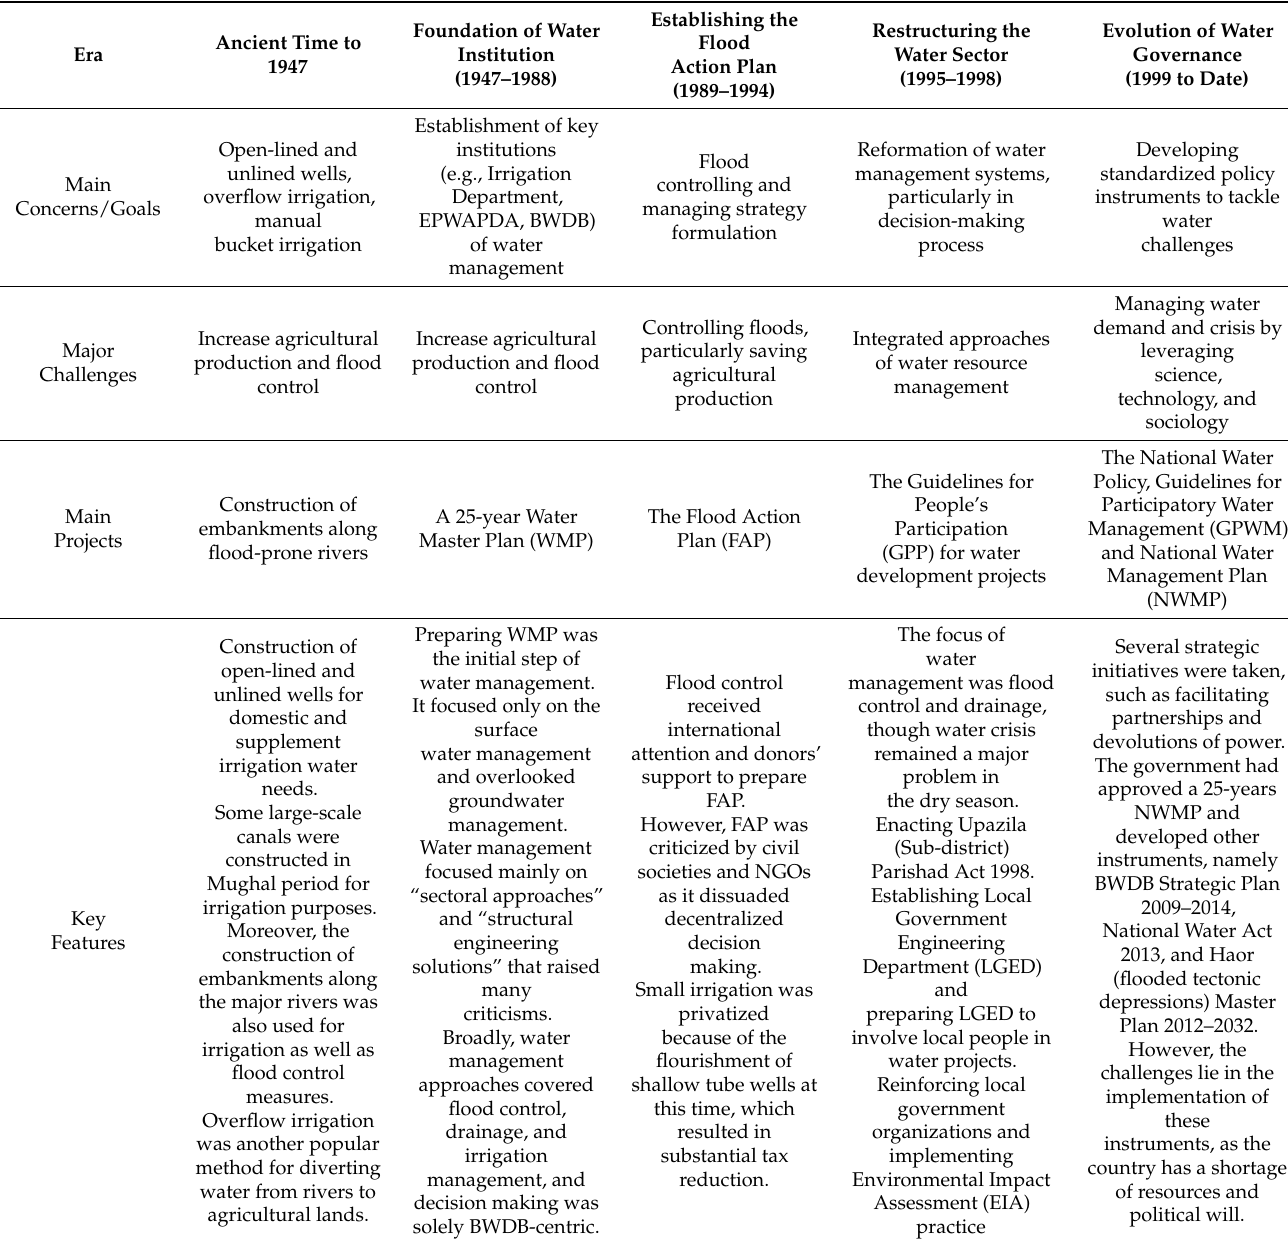
Table 1. Five eras of the evolution of water policies in Bangladesh